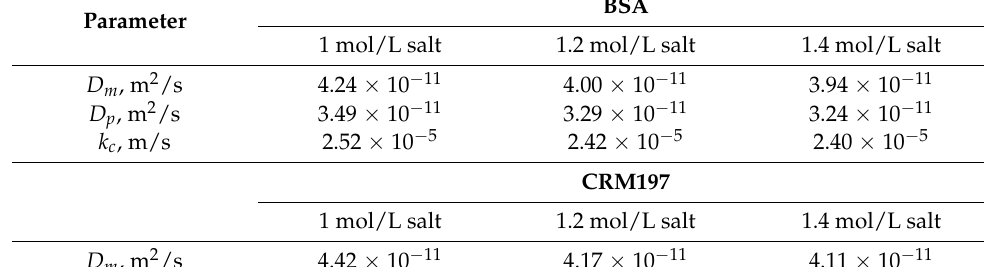
Table 7. BSA, CRM 197, and Lysozyme mass transfer parameters for different salt conditions.